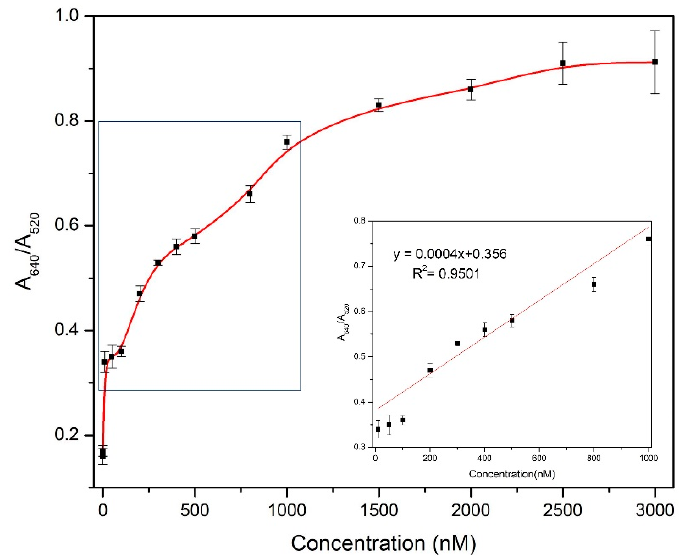
Figure 7. Calibration graph obtained from calculating the ratios of absorbance A640/A520 against increasing concentration of gentamicin (0–3000 nM). The inset shown the linear range of the biosensor, 10–1000 nM, with R 2 = 0.95.